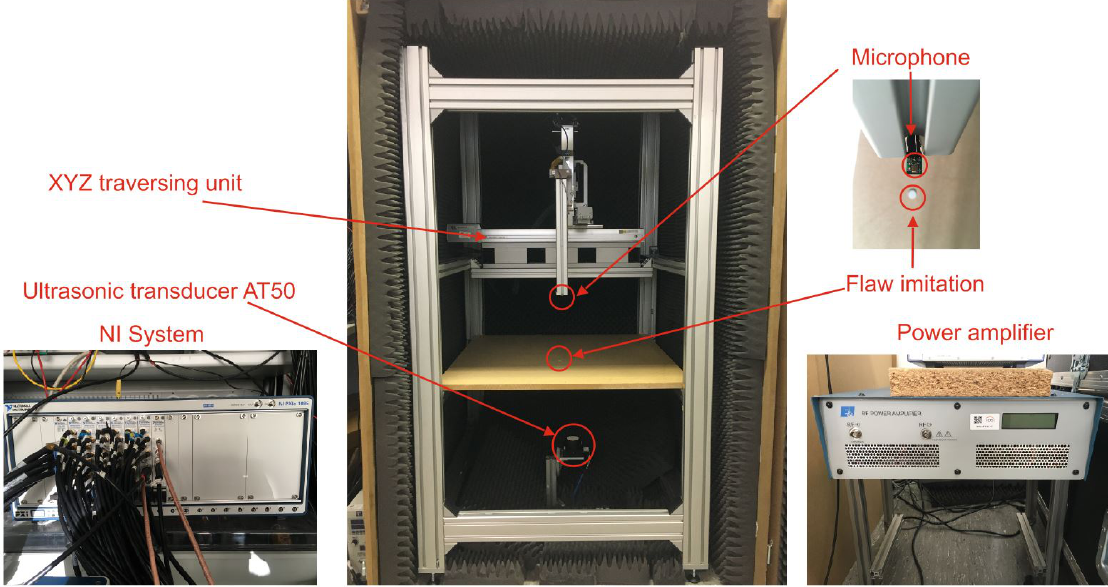
Figure 1. Experimental setup with a flaw imitation at the top of the wooden particleboard. NI = National Instruments, Schmelt et al. [22].